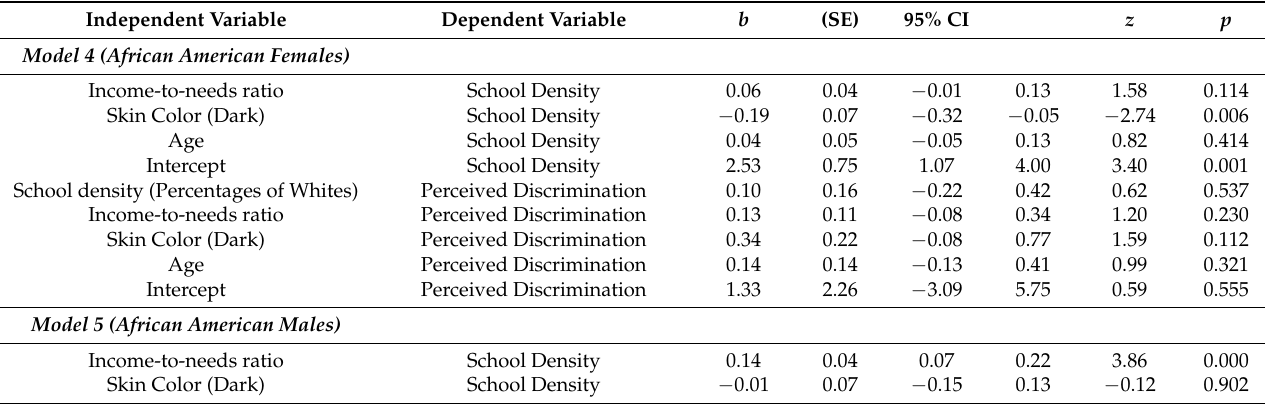
Table 3. Path coefficients for Model 4 to Model 7 in male and female African American and Caribbean Black